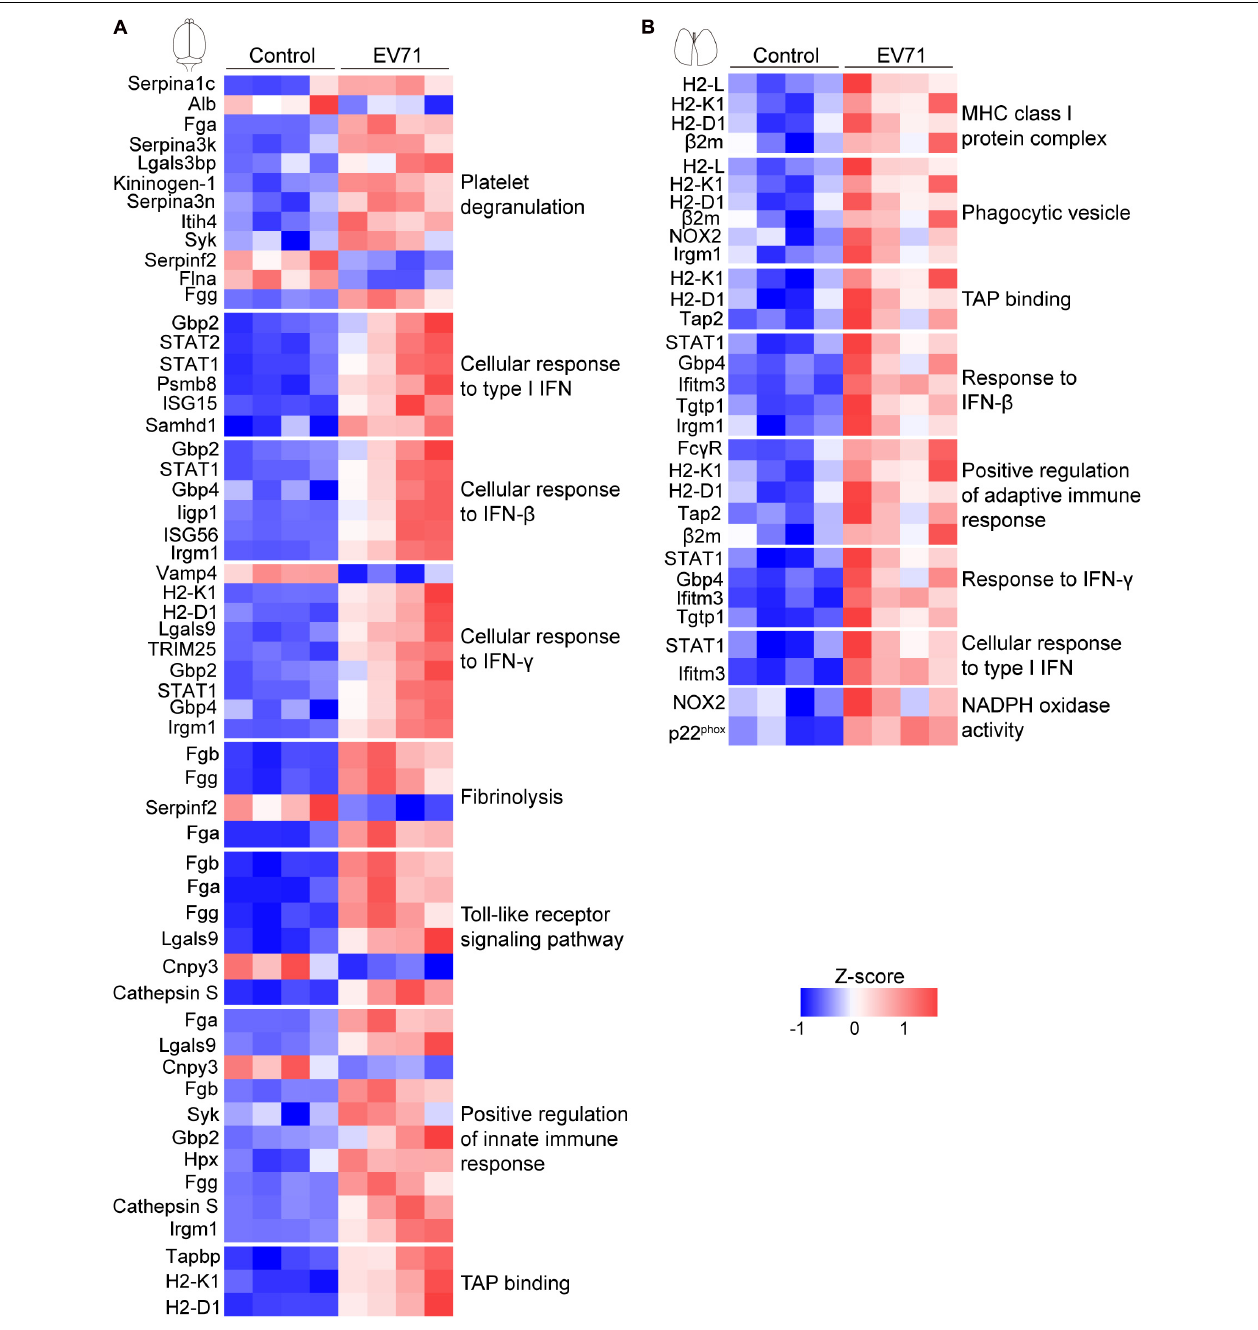
FIGURE 3 | Visualization of changing proteins and their biological pathways. (A) Heat map of differentially expressed proteins in the brain (control: n = 4, EV71: n = 4) that are involved with key biological pathways. (B) Heat map of differentially expressed proteins in the lung (control: n = 4, EV71: n = 4) that are involved with key biological